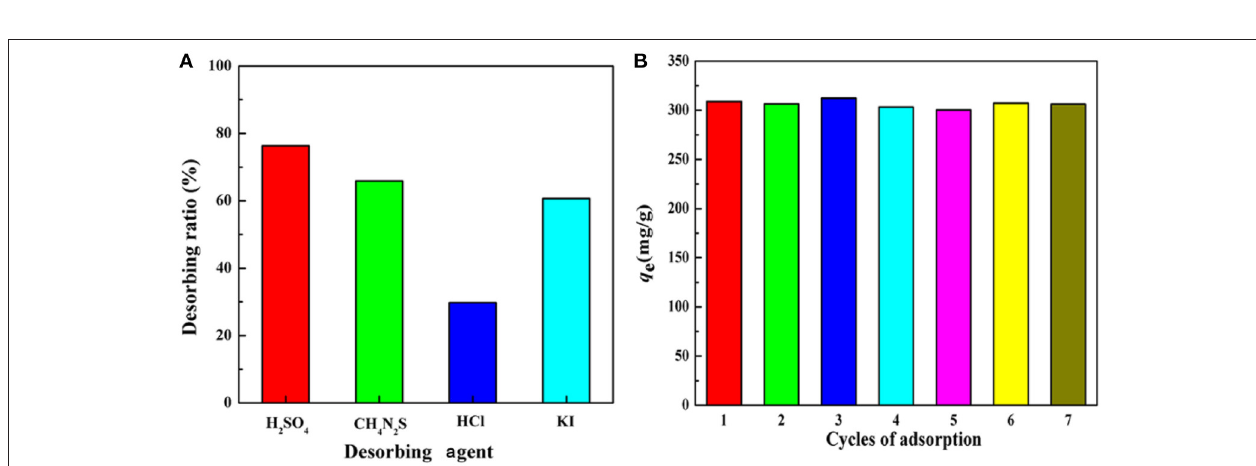
FIGURE 11 | (A) Effect of various desorbing agents on the desorption ability of KF@VIM/EGDMA adsorbent and (B) the reusability of KF@VIM/EGDMA for Hg(II) adsorption. Adsorption experiments: sample dose: 20mg/25mL; C 0 : 300mg/L; pH: 5.5; temperature: 30 ◦ C; equilibrium time: 120min. Desorption experiments: time: 300min; temperature: 30 ◦